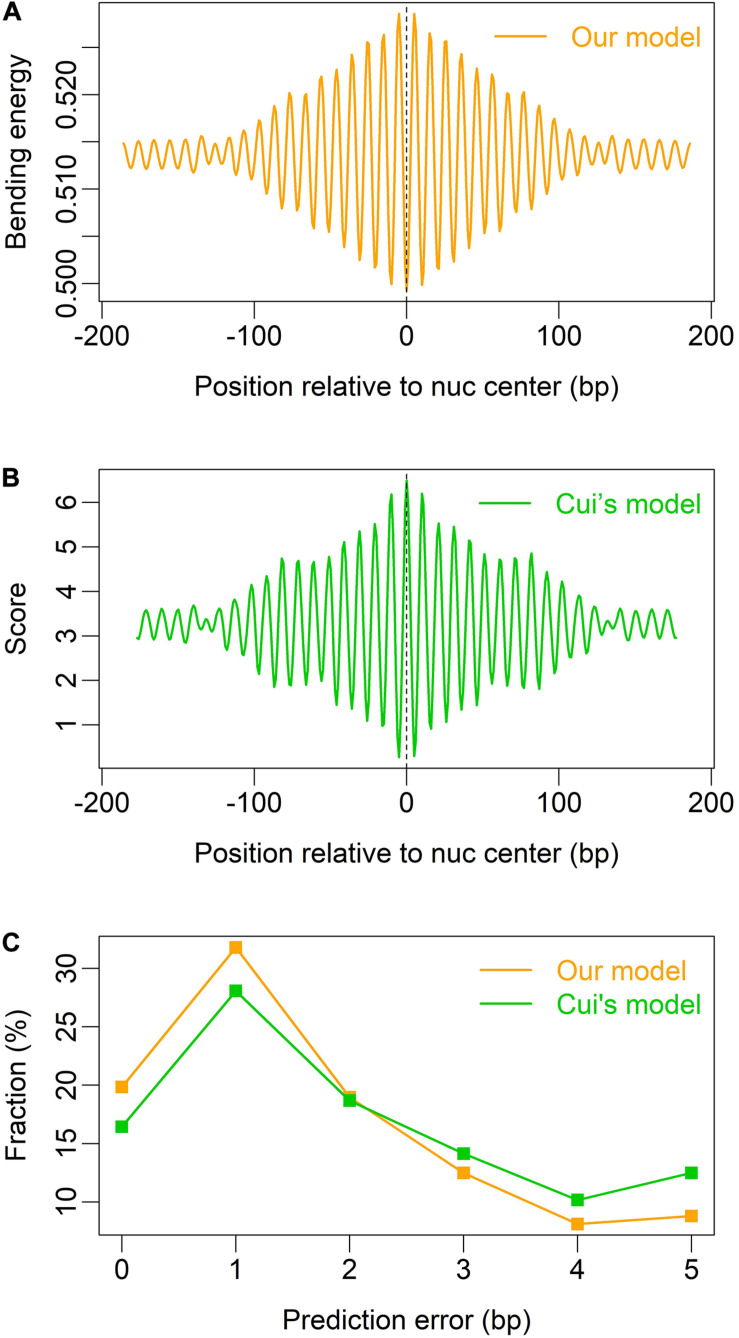
Prediction of nucleosome dyad positions (or rotational positioning) in mouse embryonic stem cells. Non-overlapping nucleosomes with NCP score >2 were analyzed (Voong et al., 2016). (A) Local bending energy minima coincide with the experimentally identified nucleosome dyad positions (Voong et al., 2016); (B) prediction based on W/S model (Cui et al., 2014); (C) comparison of prediction performance between the two models.